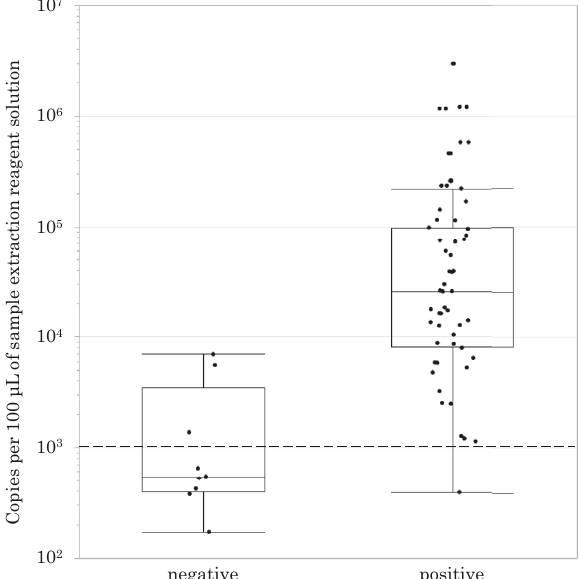
Figure 2: Relationship between copy numbers of M. pneumoniae per 100 μ